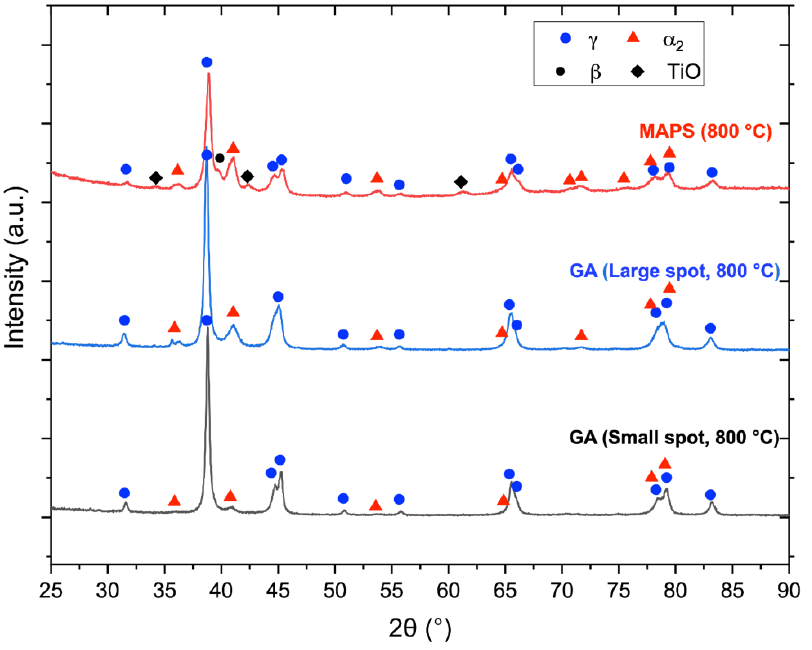
Figure 10. XRD patterns of the samples fabricated from GA and MAPS powders.